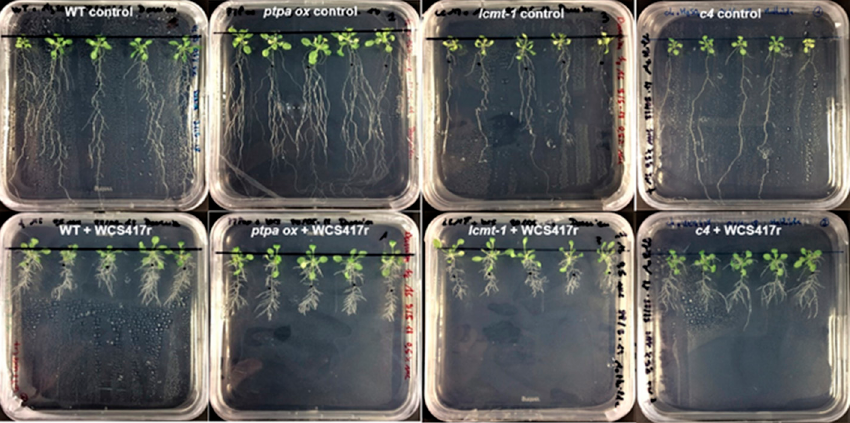
Figure 3. Visual phenotype of Arabidopsis WT and mutants treated with P. simiae WCS417r. Seedlings of Arabidopsis WT and mutants ( ptpa ox , lcmt1 , c4 ) cultivated without (upper row) and with P. simiae WCS417r (lower row) for two weeks.